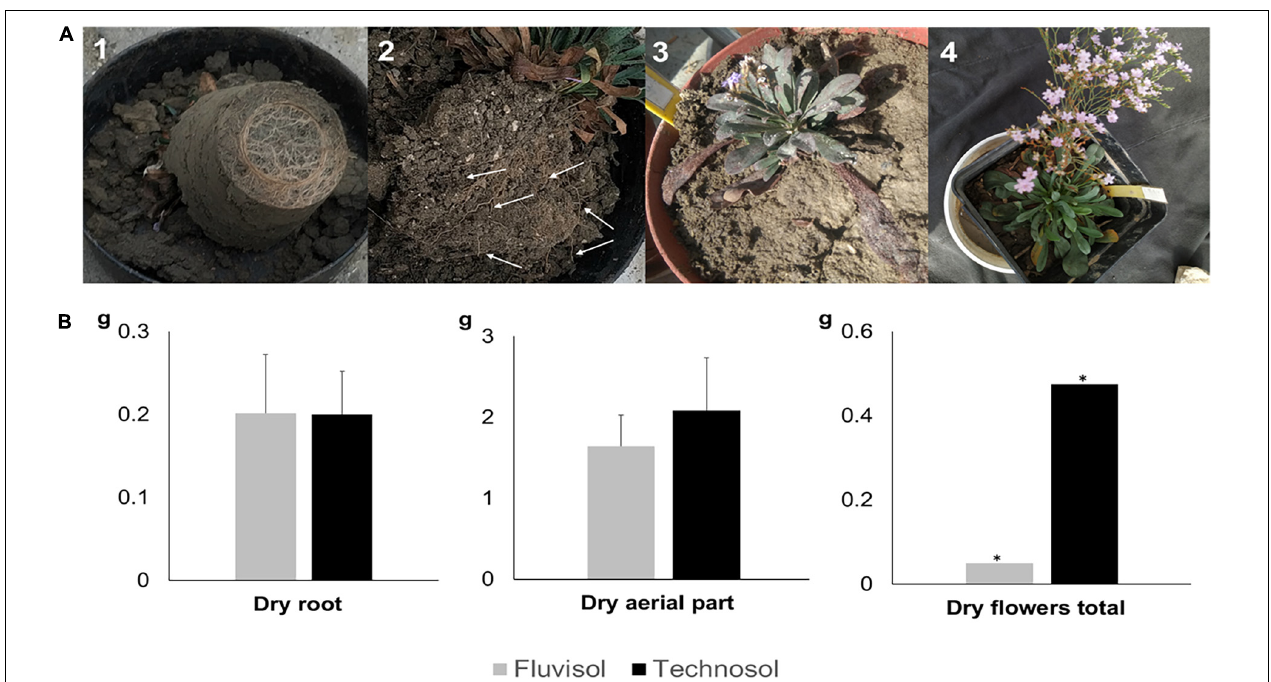
FIGURE 6 | Biomass production at the end of the microcosm assay using brackish water irrigation (A) Fresh biomass produced. (A1) Plant roots cultivated in Fluvisol concentrated at bottom of the pot. (A2) Plant roots (white arrows) grown in Technosol spreading uniformly over the soil. (A3) Plant grown in Fluvisol exhibiting one scape. (A4) Plant cultivated in Technosol showing two scapes. (B) Dry biomass of leaves, roots, and flowers [mean ± SD (except dry flowers total); n = 5]. The aerial part represents the leaves and scapes; *, only one individual produced scapes. No significant differences were found between substrata ( p > 0.05, one-way ANOVA followed by Tukey HSD test).